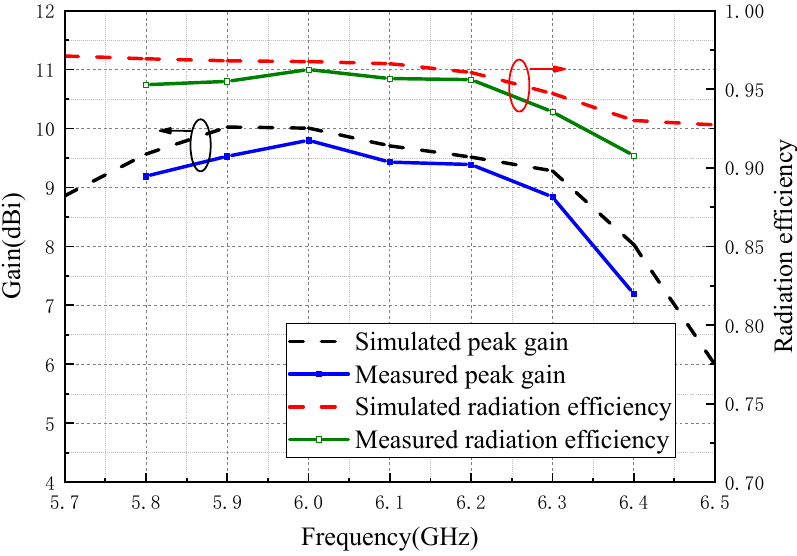
Figure 12. Simulated and measured peak gain and radiation efficiency of the proposed antenna.